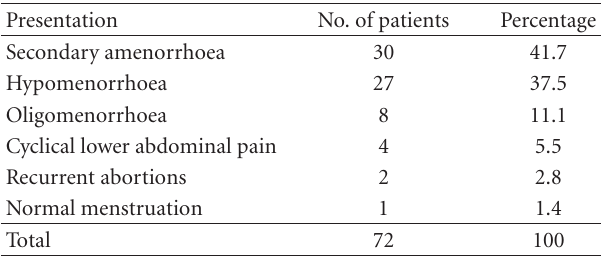
Table 4: Clinical presentation.